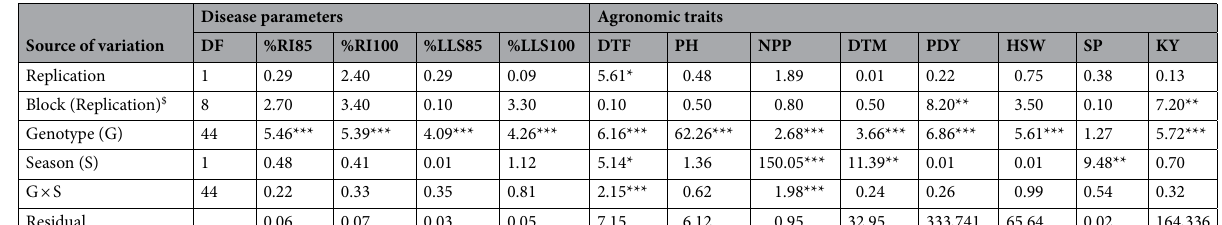
Table 4. Analysis of variance showing F-statistic values for four disease parameters and eight agronomic traits of 45 groundnut genotypes evaluated in two seasons in Tanzania. DF degrees of freedom, %RI85 percentage rust infection at 85 days after planting, %RI100 percentage rust score infection at 100 days after planting, %LLSI 85 percentage late leaf spot infection at 85 days after planting, %LLSI 100 percentage late leaf spot infection at 100 days after planting, DTF days to flowering, PH plant height, NPP number of pods per plant, DTM days to maturity, PDY pod yield, HSW hundred seed weight, SP shelling percent, KY kernel yield. $ Indicates chi-square statistic. *,** and *** represent significant differences at 0.05, 0.01 and 0.001 probability levels,